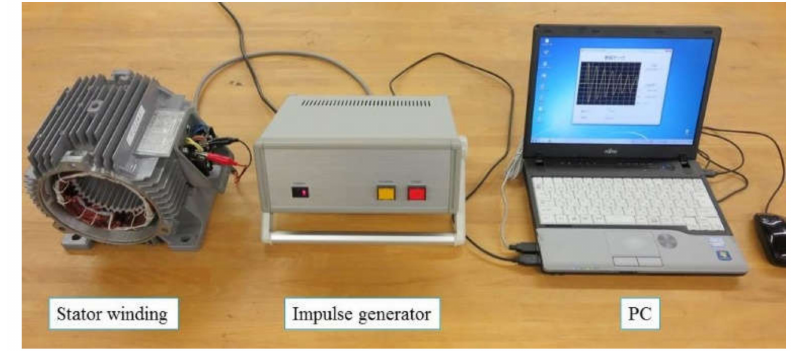
Figure 2. Developed impulse generator.